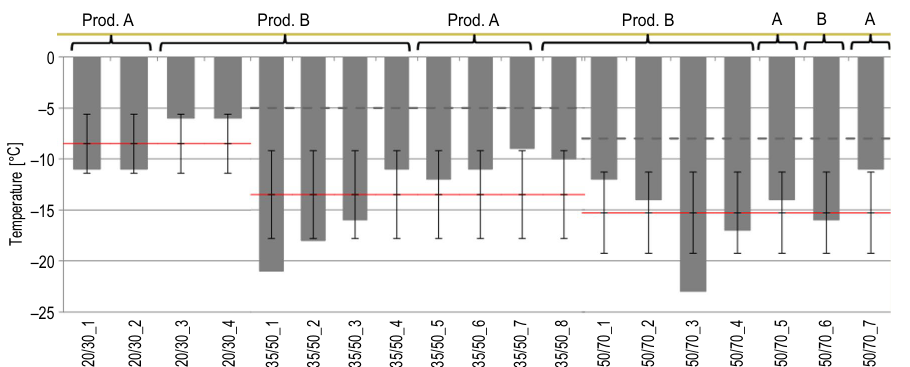
Fig. 3. Unmodified bitumen Fraass breaking point